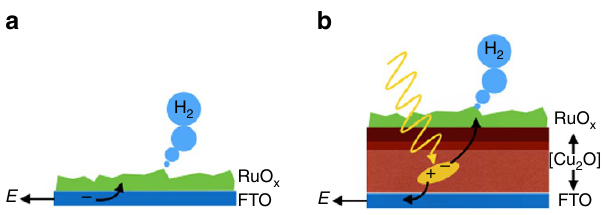
Figure 1 | Schematic representation of the dark and light electrocatalytic systems. ( a ) RuO x /FTO cathode and ( b ) FTO/Cu 2 O/AZO/TiO 2 /RuO x photocathode. The diagram is not scaled.